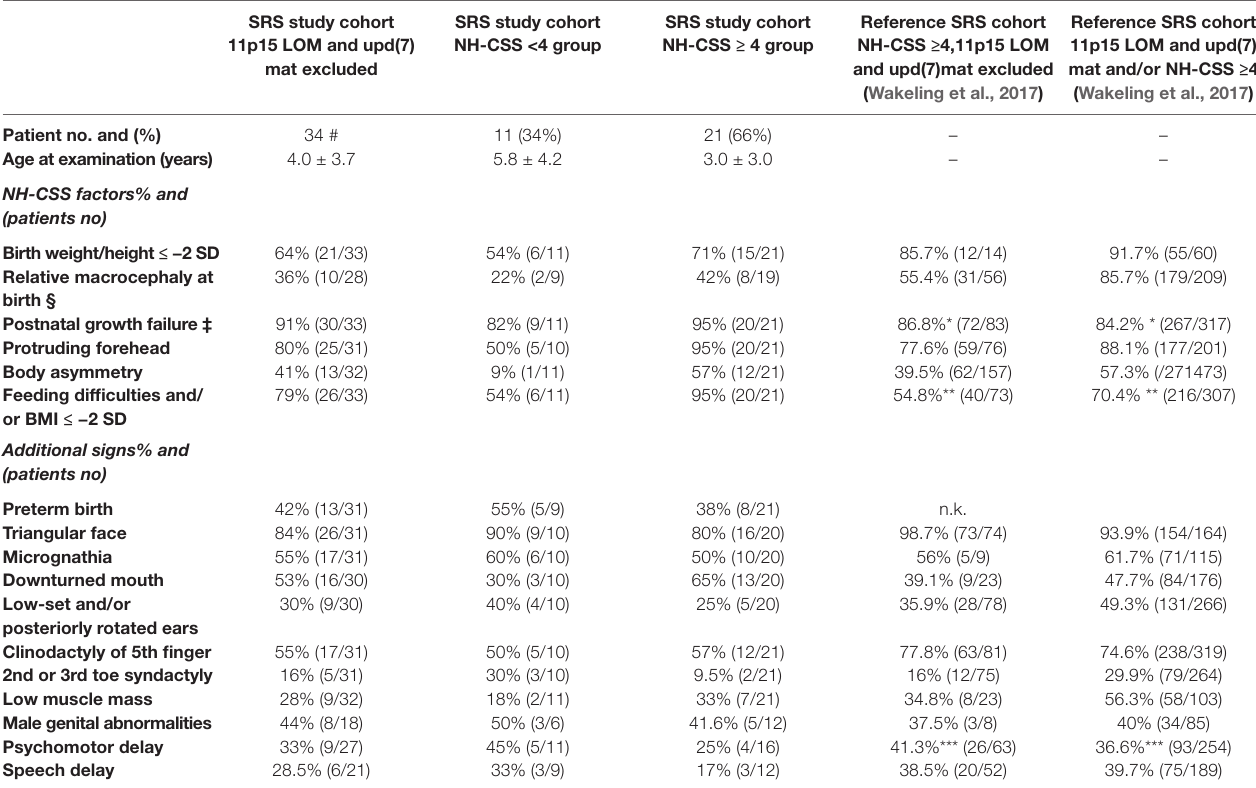
TABlE 1 | Distribution of our SRS cohort, negative to 11p15 defects and upd(7)mat, according to NH-CSS criteria and comparison with